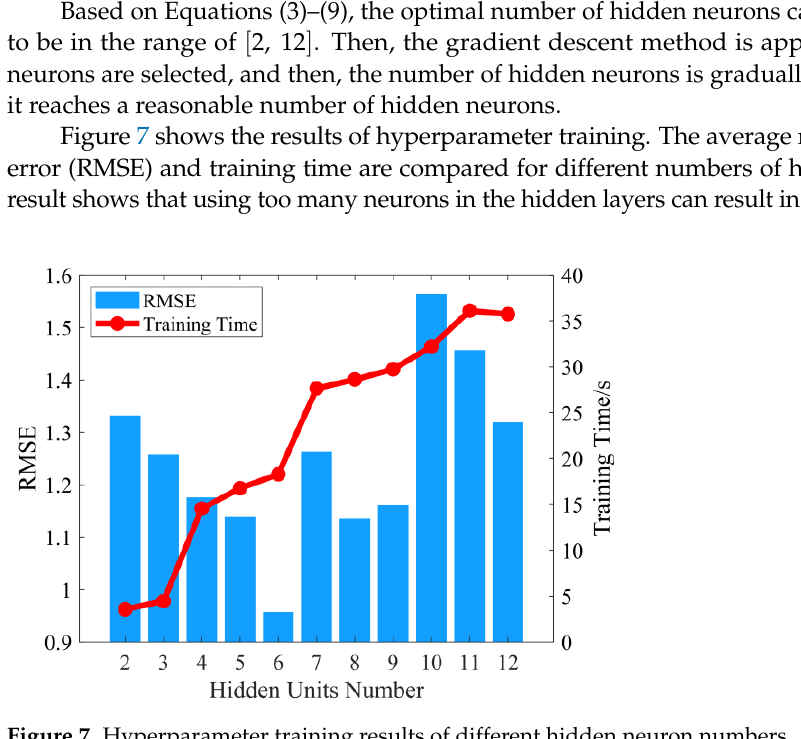
Figure 7. Hyperparameter training results of different hidden neuron numbers.